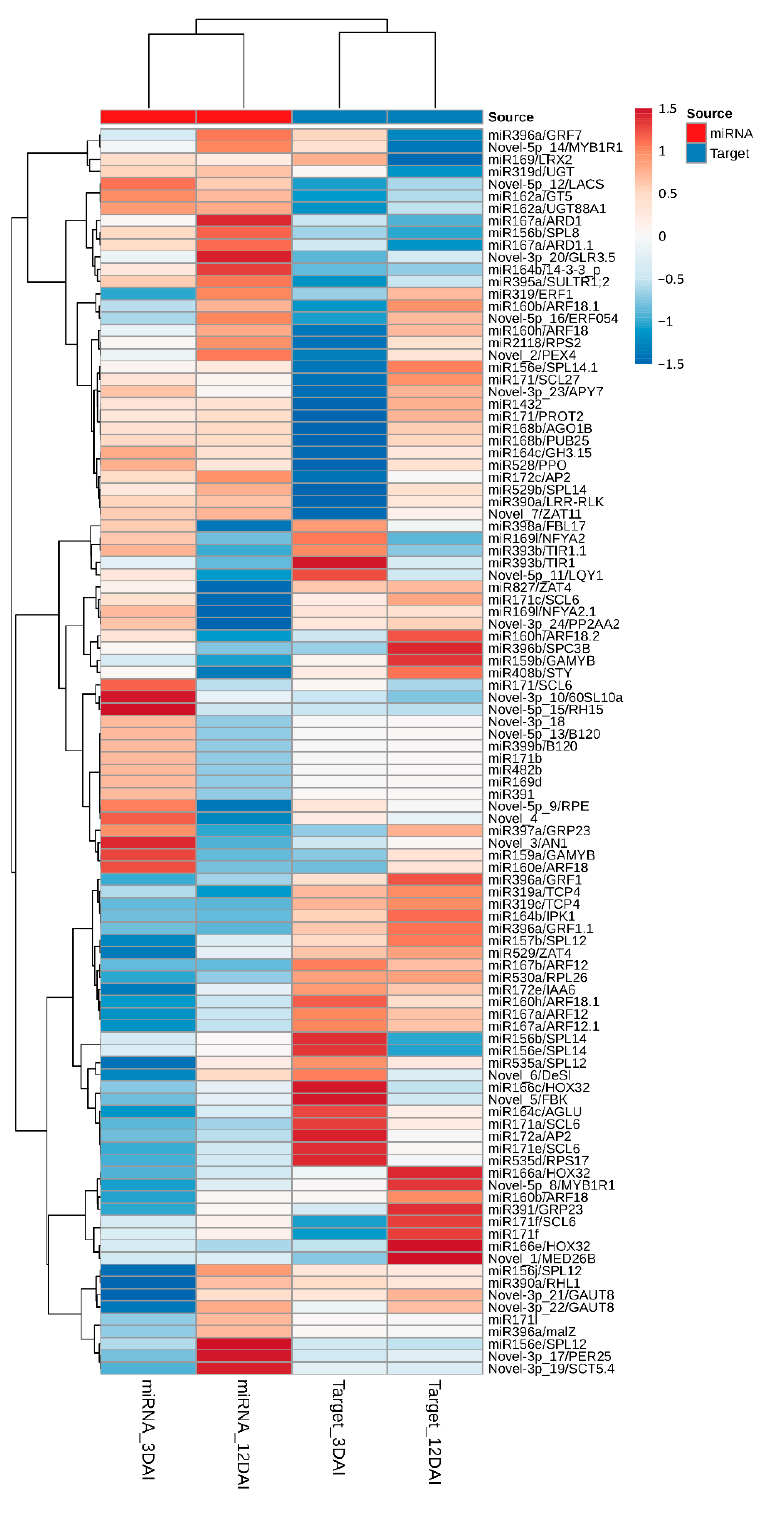
Figure 5. Hierarchical clustering heatmap of differentially expressed Musa acuminata var. Calcutta 4 miRNAs and target genes. Log2Fold-based changes in gene expression represent Pseudocercospora musae -inoculated treatments in relation to non-inoculated controls at each time point (3 and 12 days after inoculation). Original in silico expression values for the miRNAs and target genes were normalized with EdgeR. Changes in expression were depicted from high (red) to low (blue), according to the colour scale. Abbreviation: DAI, days after inoculation.